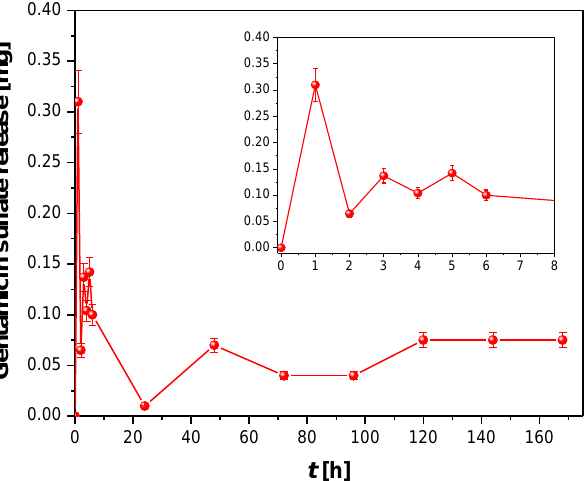
Figure 14. Gentamicin sulfate release from ONTs on the Ti–6Al–7Nb alloy as a function of immersion time in phosphate-buffered solution. The inset corresponds to the first 6 h of drug release.